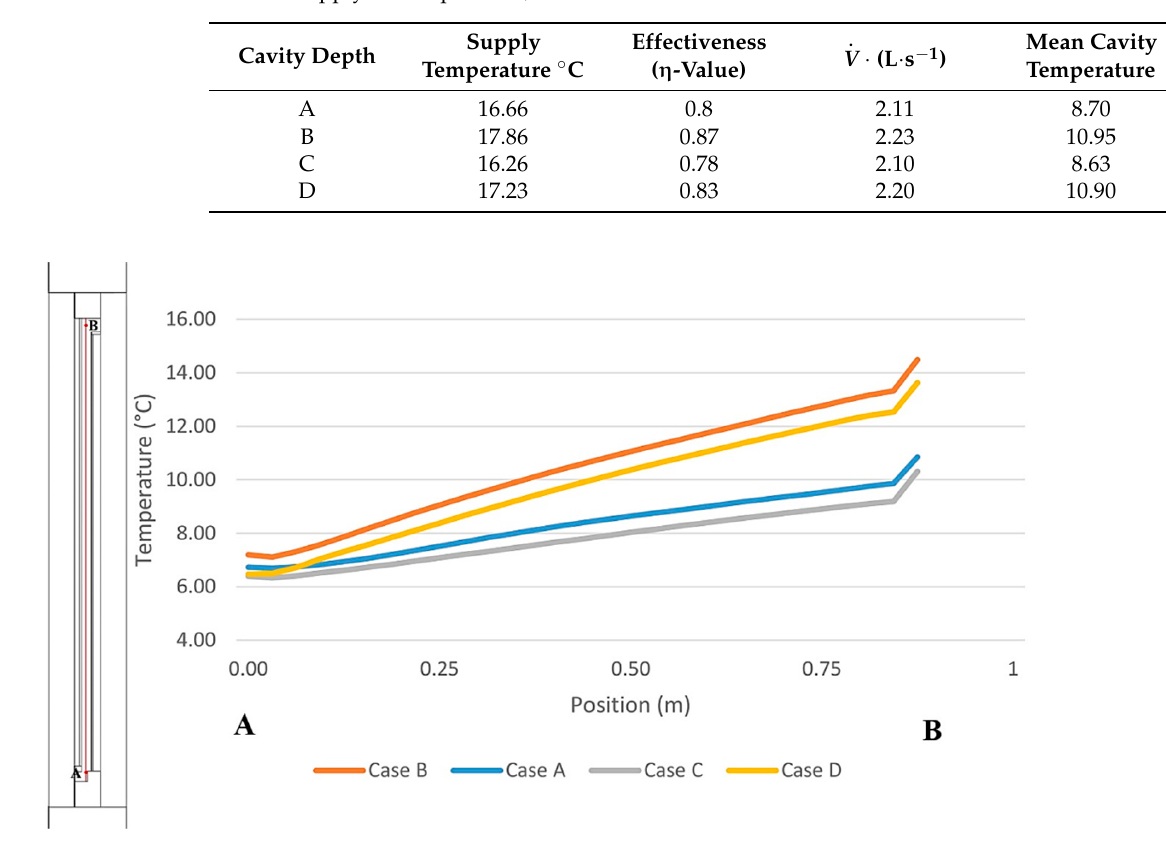
Figure 9. Simulated temperature distribution in window’s cavity space.